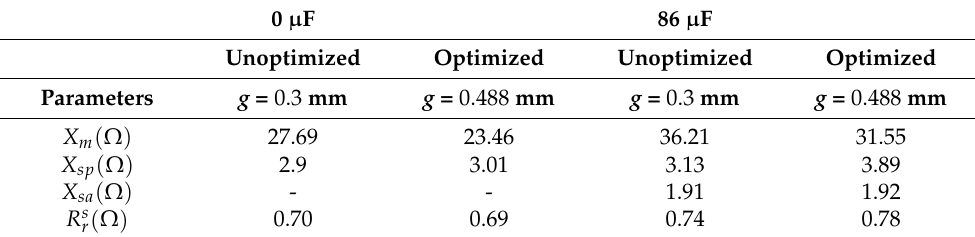
Table 8. Parameters for optimized and unoptimized